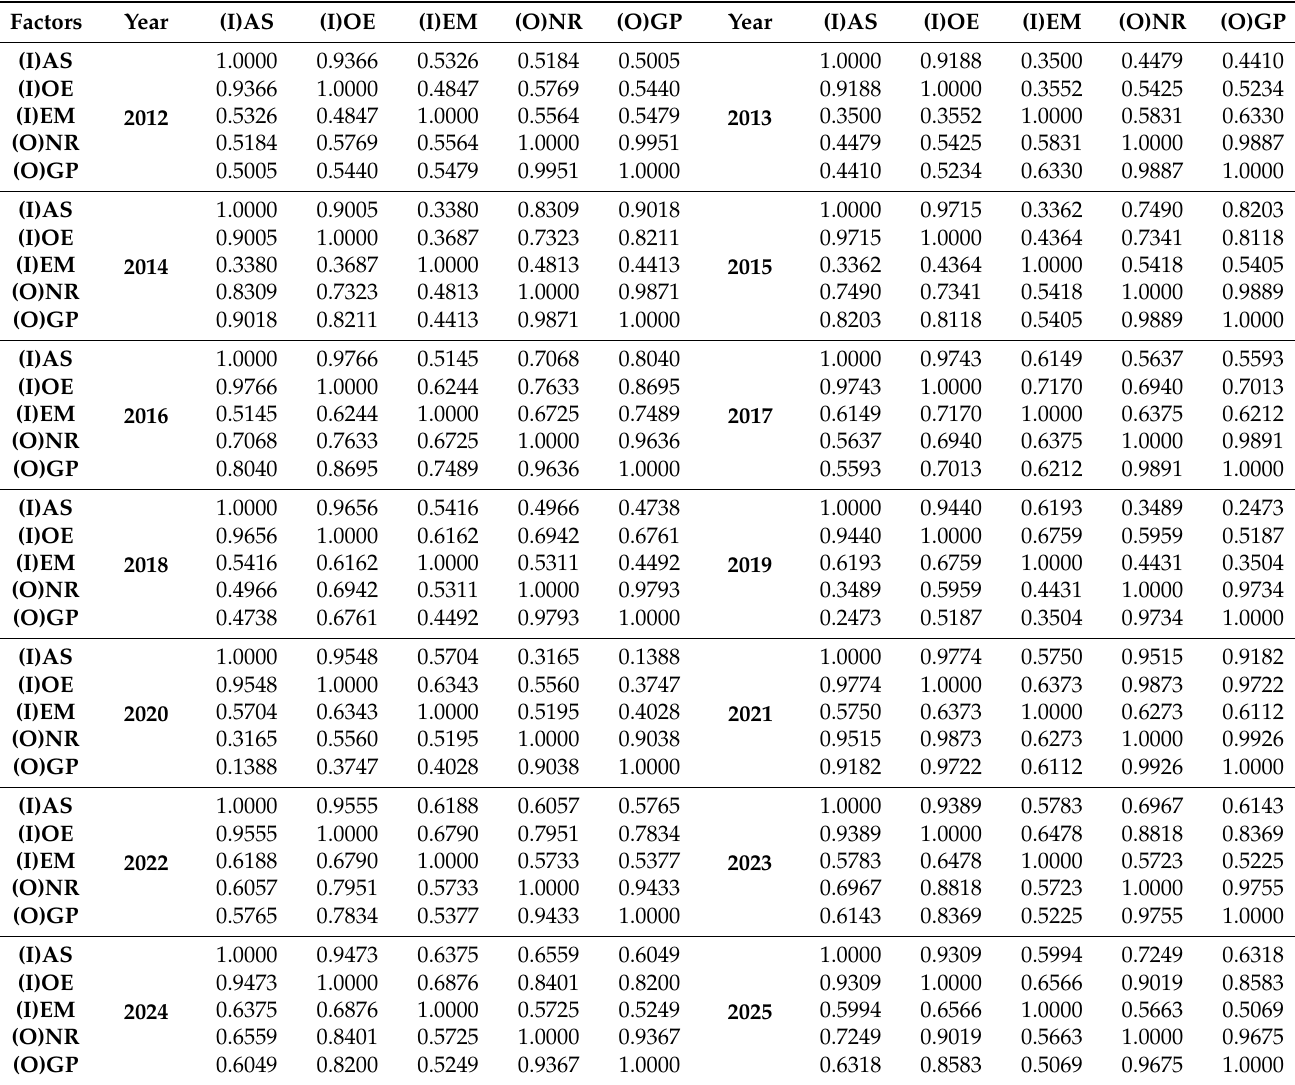
Table A2. Pearson Correlation from 2012 to